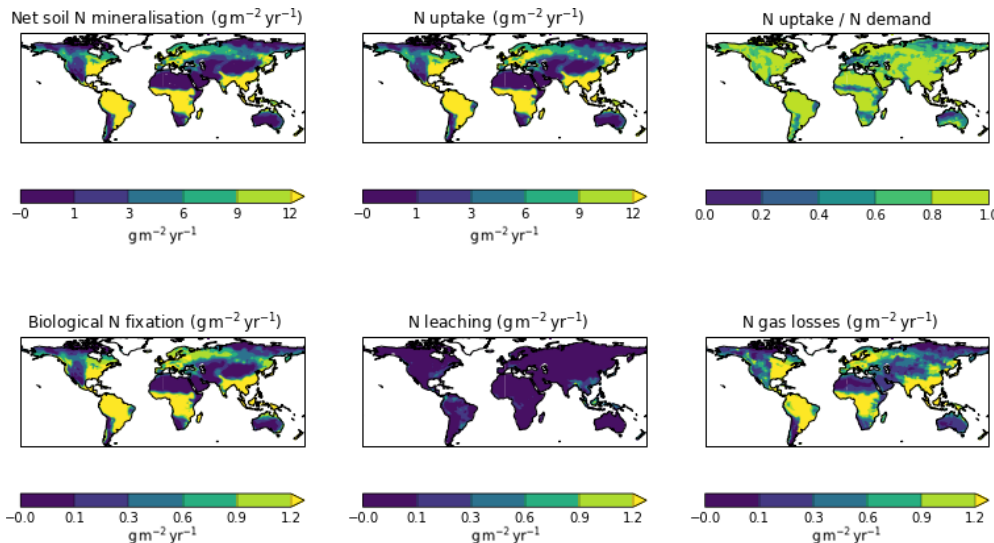
Figure 12. Spatial distribution of N fluxes for JULES-CN for the period 1996–2005. JULES-CN layer is not shown because the spatial patterns are very similar to those for JULES-CN.